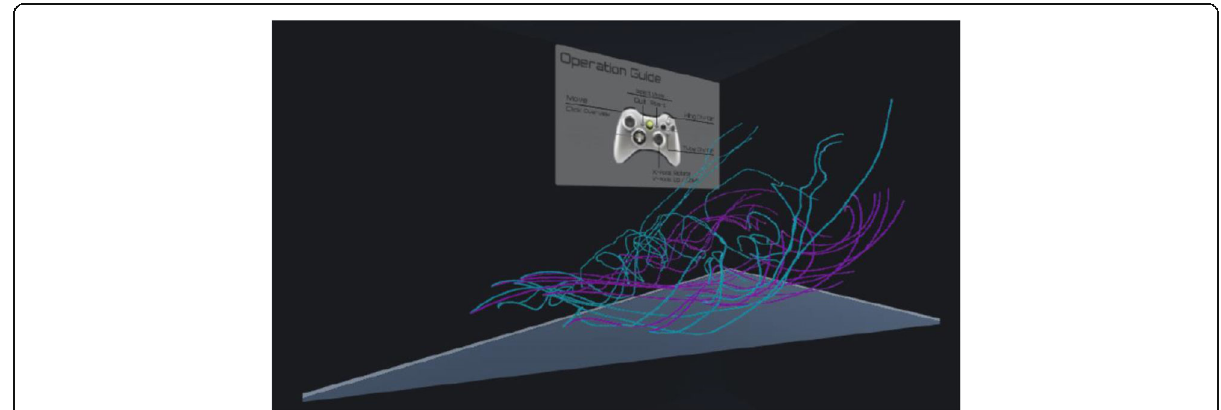
Fig. 11 Example of streamlines in a VR